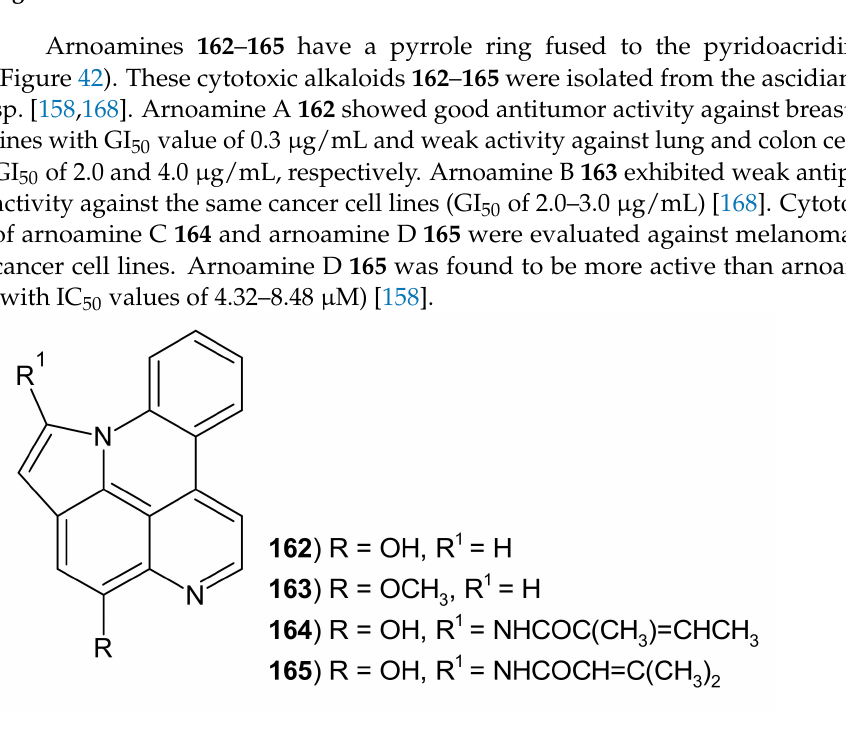
Figure 42. Arnoamines